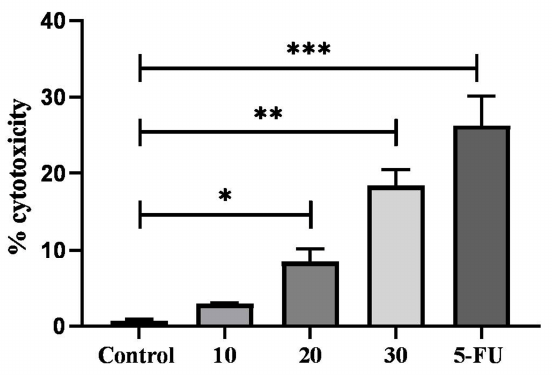
Figure 5. HCT-116 cells were treated with increasing concentrations (10, 20, and 30 µg/mL) of TYH. 5-FU (10 µg/mL) was used as positive control. Incubation was carried out for 48 h. Release of LDH was detected using CyQUANT™LDH Cytotoxicity Assay Kit. Data are represented as mean ± SD ( n = 3), (*** p < 0.001; ** p < 0.01; * p < 0.05) vs. control.